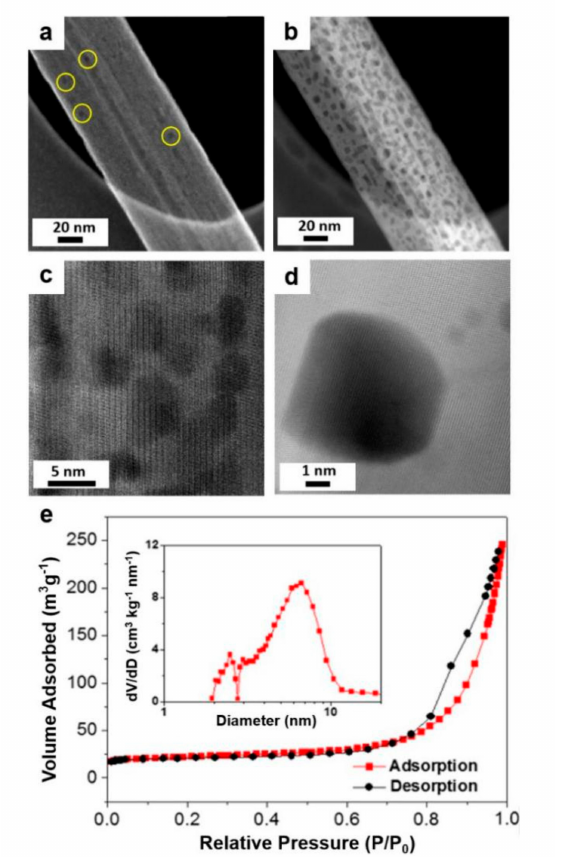
Figure 4. ( a ) High magnification SEM image, highlighting one single TiO 2 -B nanobelt with pores, ( b ) TEM image of mesoporous TiO 2 -B nanobelts, revealing homogeneous nanopores, ( c ) high-angle annular dark-field scanning transmission electron microscope (HAADF-STEM) image of single mesoporous TiO 2 -B nanobelt, ( d ) magnified pore image in (c), and ( e ) N 2 adsorption-desorption isotherm of the mesoporous TiO 2 -B nanobelts. Inset: the corresponding pore size distribution calculated by the Barrett-Joyner-Halenda (BJH) method from the adsorption curve.